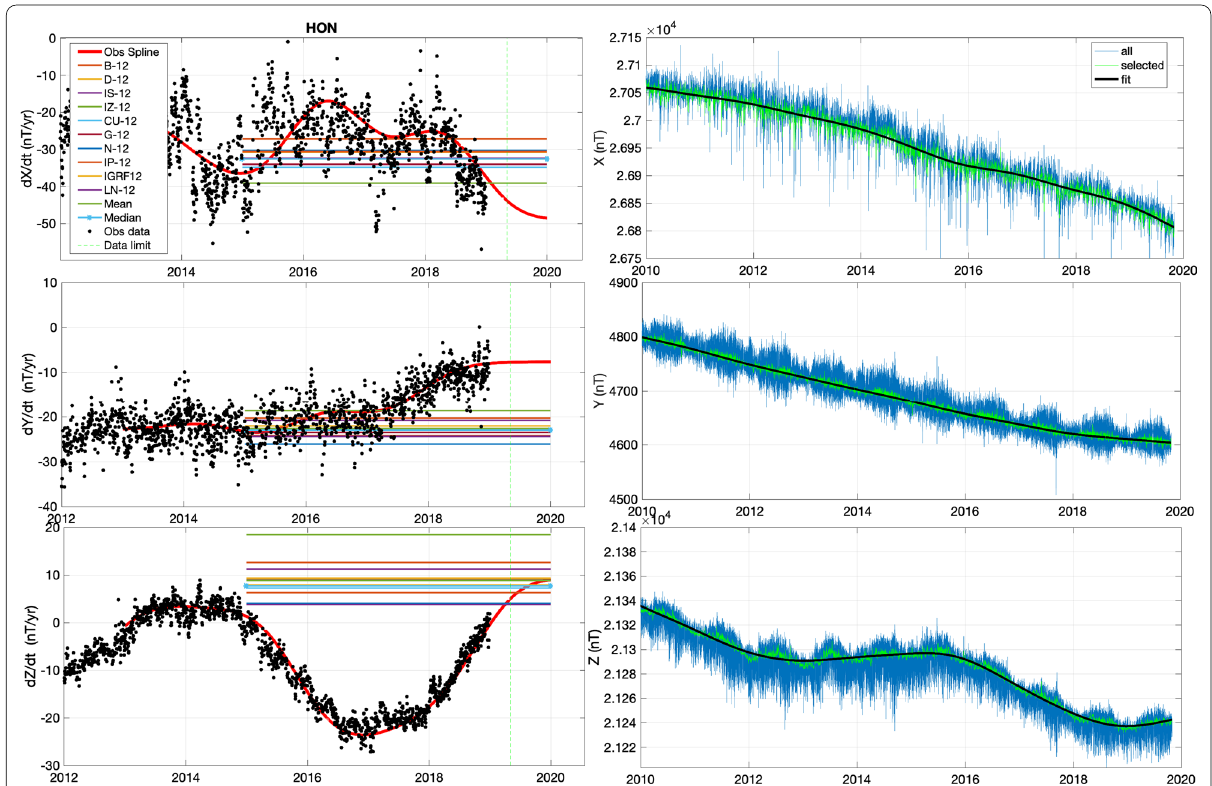
Fig. 12 IGRF12 retroactive SV comparison at Honolulu (HON). Left panels show the observatory annual differences of daily mean values (black), annual spline difference curve (red) and IGRF12 candidate predictions for the d B x / d t (top), d B y / d t (middle), and d B z / d t (bottom) components in the NEC frame. Right panels show the original observatory data (blue), data after selecting for geomagnetically quiet periods (green), and fitted spline curve (black) for the B x (top), B y (middle) and B z (bottom)